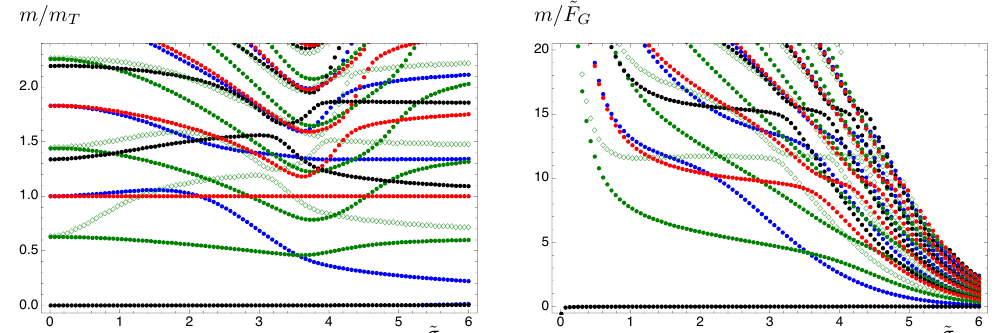
= 8 when extracting the 2